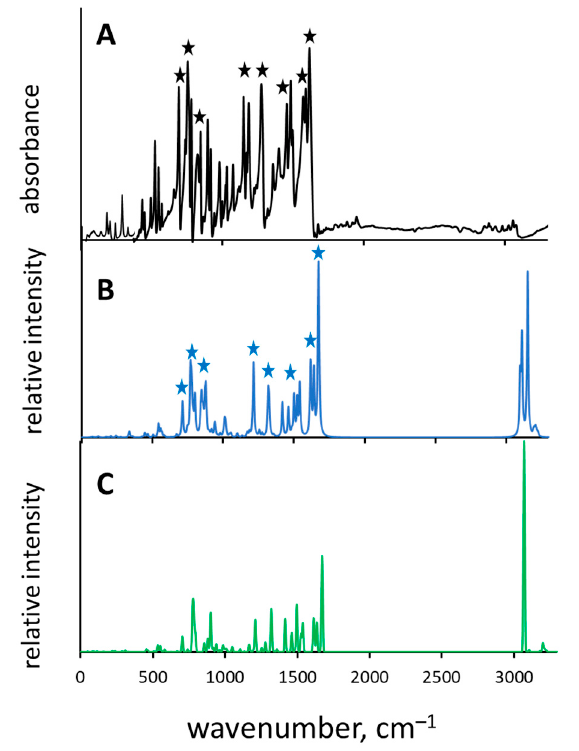
Figure 5. Normalized IR experimental (( A ), black trace; measured at 295 K) and calculated by DFPT method spectra of polymorphs α 2 (( B ), blue trace) and β (( C ), green trace) of SA . Black and blue asterisks: the most informative bands, allowing one to identify polymorph α 2 . See text for more details.